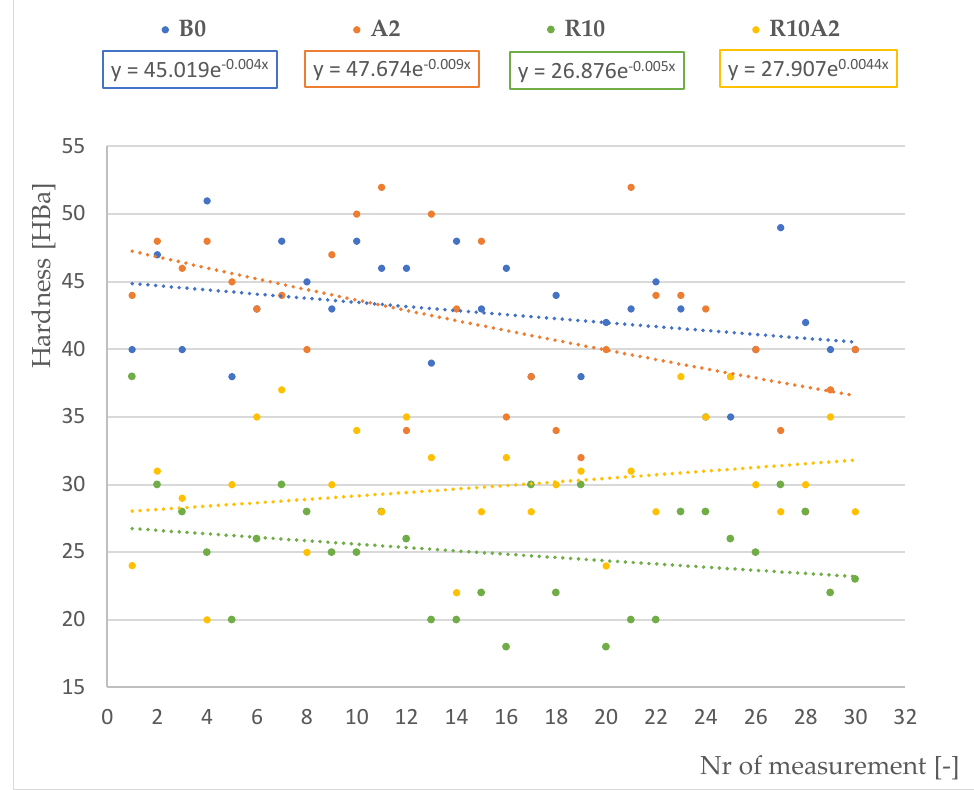
Figure 2. Hardness test results for four variants of composite materials.